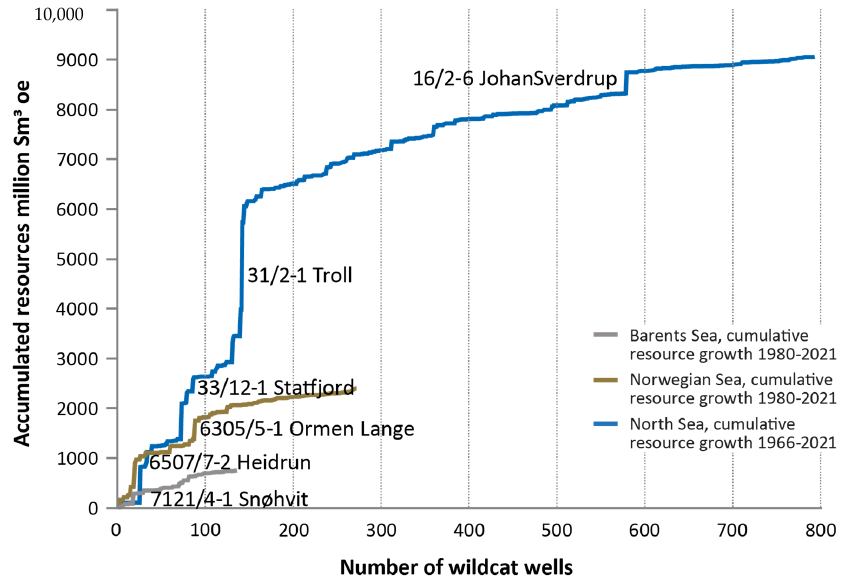
Figure 3. Volumes of explored gas reserves in offshore fields in Norway. Source: [54].